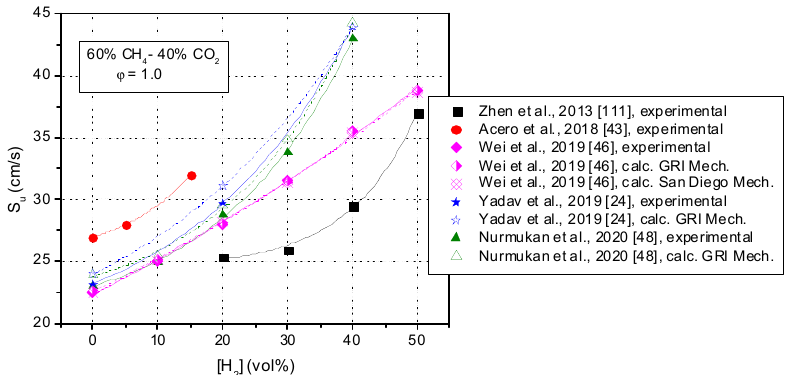
Figure 14. Comparison of the experimental and numerical results referring to the stoichiometric mixture, at standard initial conditions and various hydrogen content.